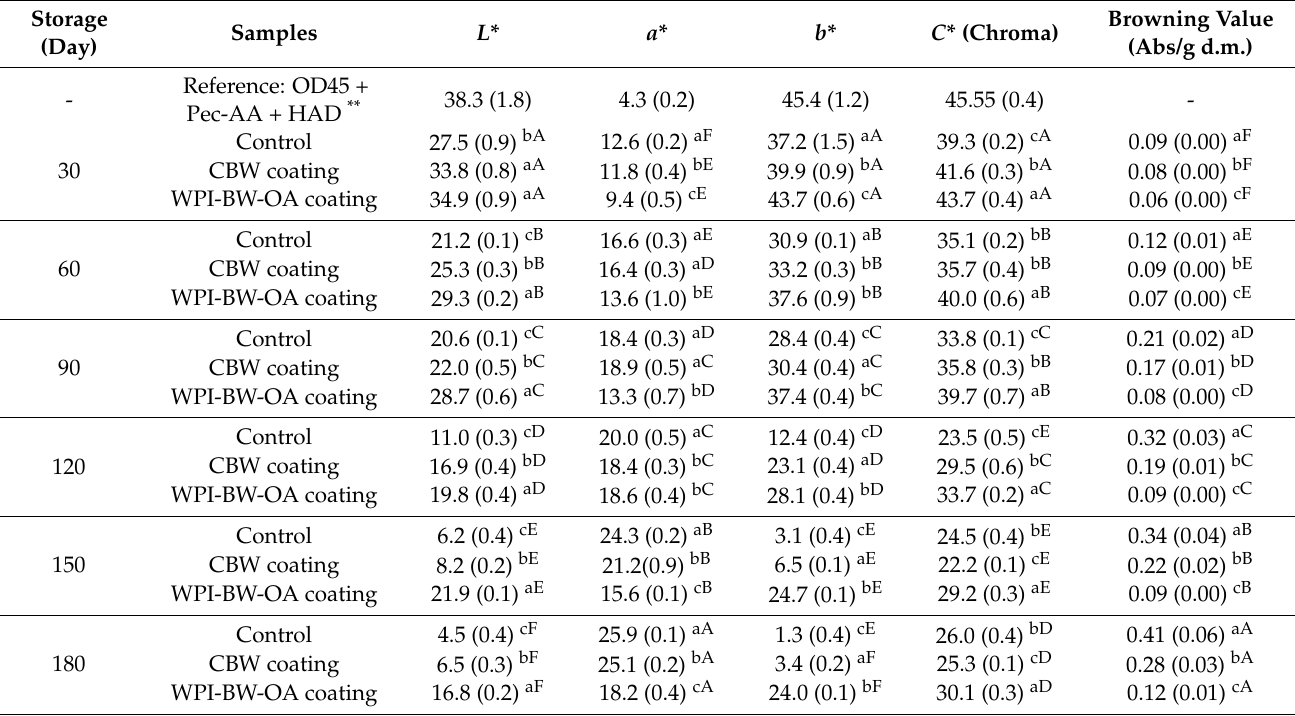
Table 3. Effect of different types of composite coating after HAD and storage time on color attributes of semi-moist dried apricot in breakfast